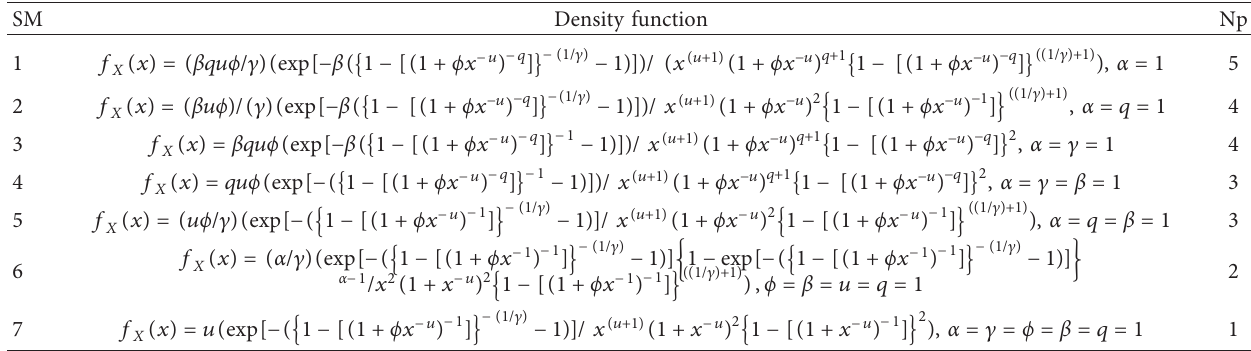
Table 8: Submodels of EEDL